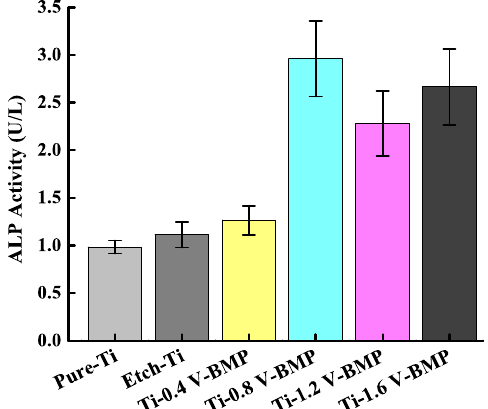
Figure 8. In vitro cell alkaline phosphatase (ALP) activity of MG-63 cells cultured on HAp/BMP-2 coprecipitation samples.